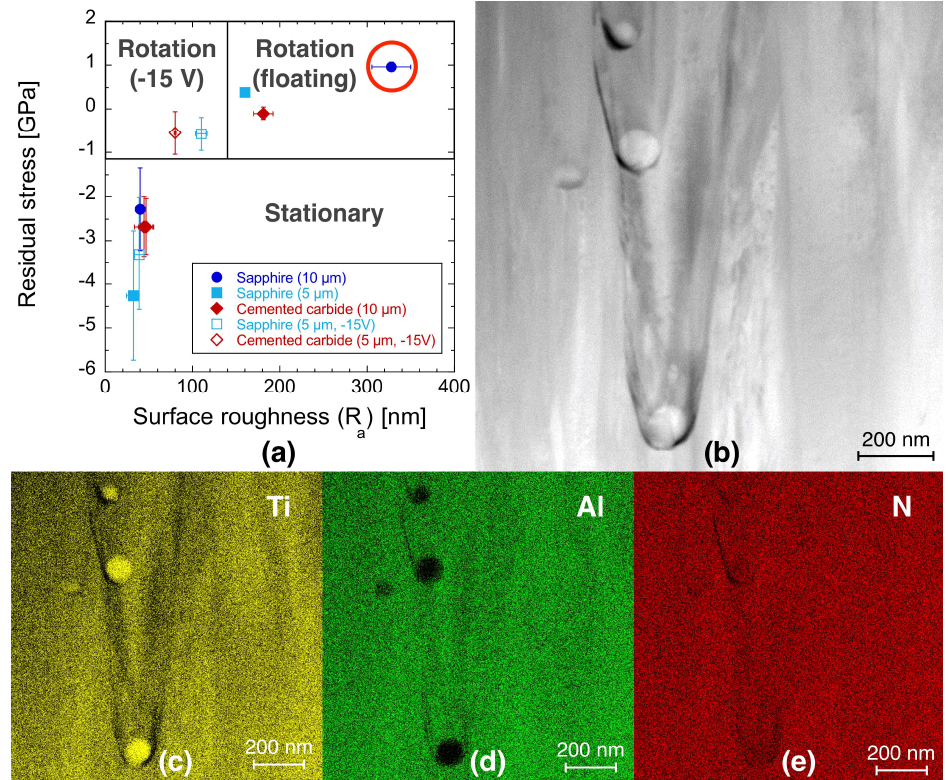
Figure 5. ( a ) Residual stress state as a function of the surface roughness ( R a ), which represents an indirect measure of the macroparticle surface coverage. The data point highlighted with a circle indicates the selected coating for ( b ) microstructural and ( c – e ) spatially resolved chemical composition characterization